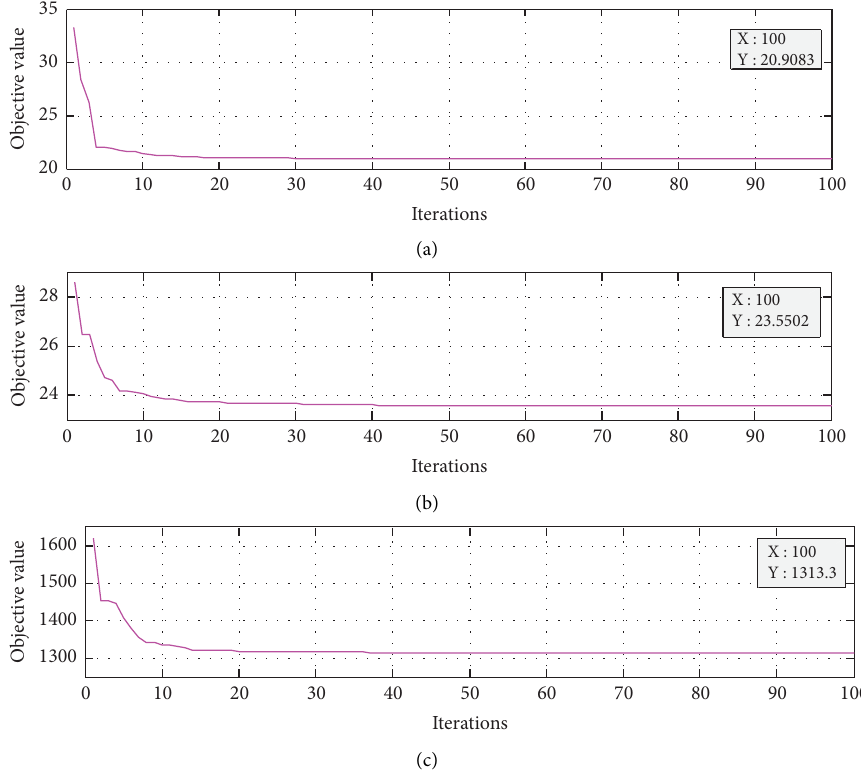
Figure 8: Convergence characteristic curves for new multiobjective OPF (Case 14 through case 16) of the IEEE 30-bus system: (a) Case 14; (b) Case 15; (c) Case